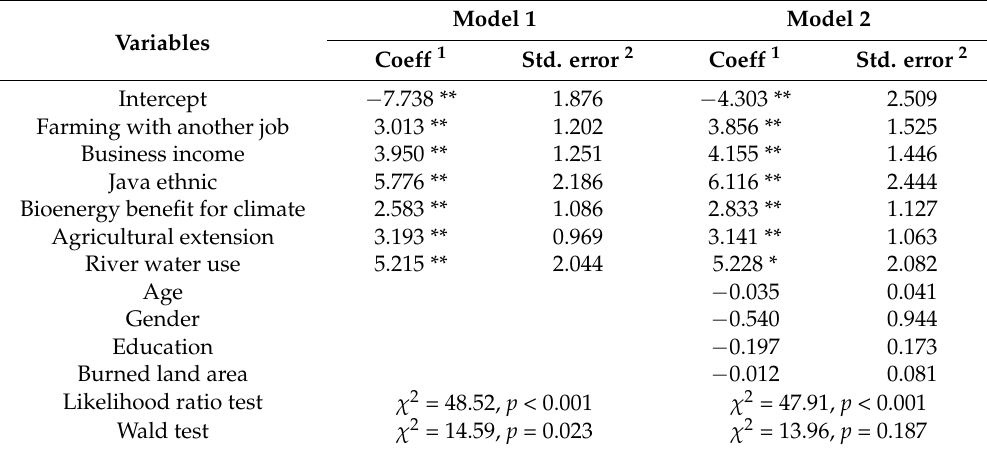
Table 3. Results of Firth’s logistic model showing landowner preferences for bioenergy production on degraded lands ( n =